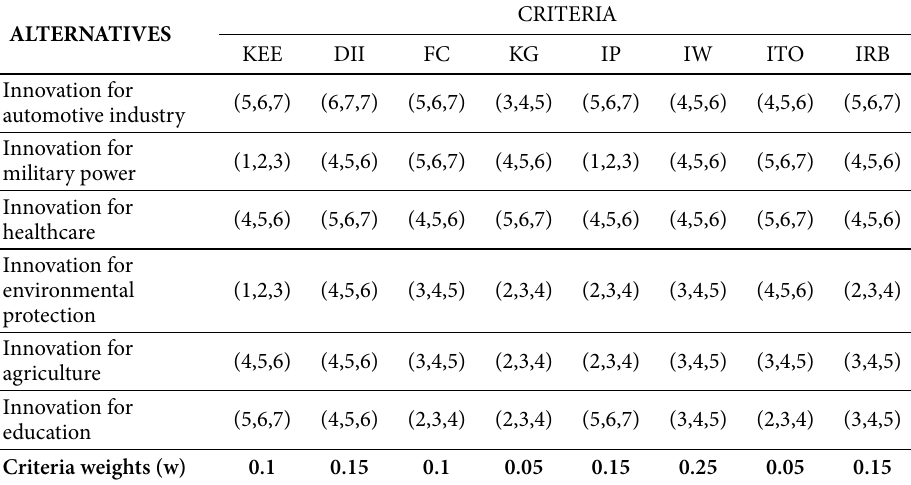
Table 3. Decision matrix with numerical